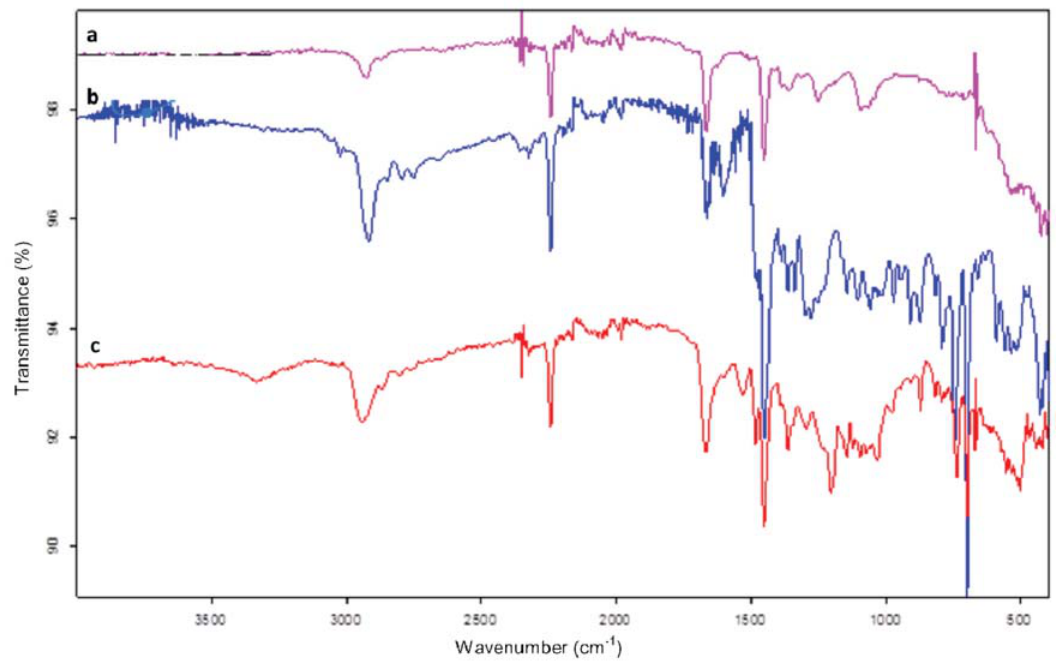
Figure 4. FTIR (ATR) spectra of prepared nanofibers. (a: pure PAN, and b: PAN-CLX3 and c: